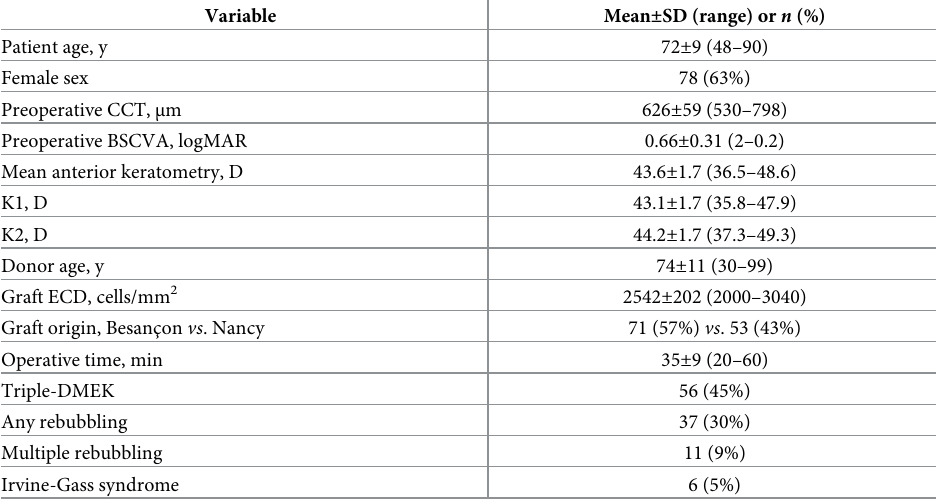
Table 2. Baseline and operative characteristics of the cohort ( n = 124 eyes and 124